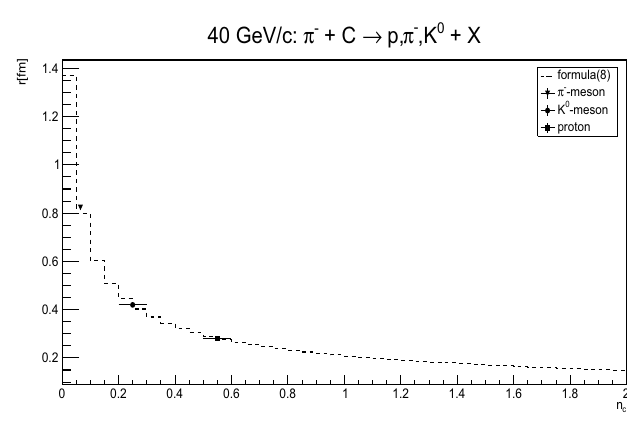
Figure 7. Particle emission region size as a function of n c